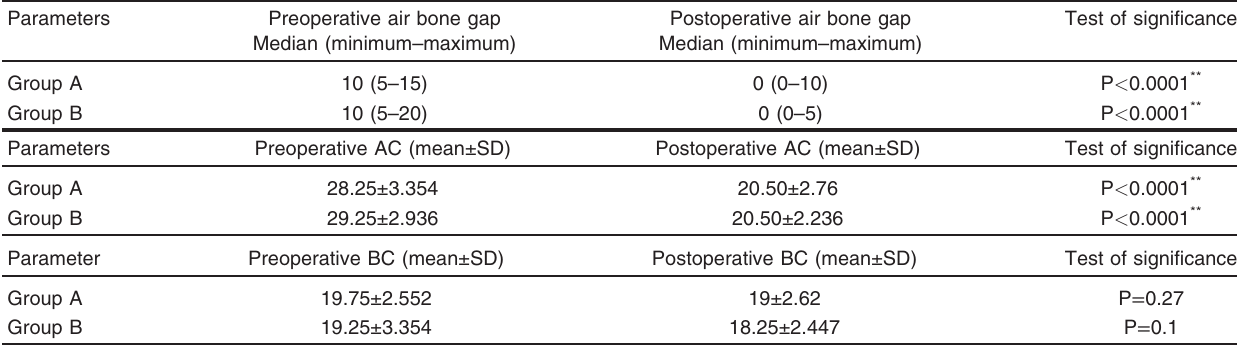
Table 3 Comparison of the air conduction, BC, and air bone gap preoperative and postoperative for each studied groups Parameters